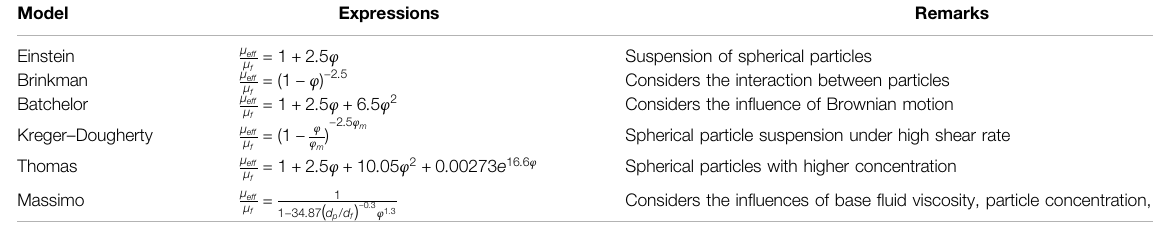
TABLE 3 | Viscosity calculation models for nano fl uids.